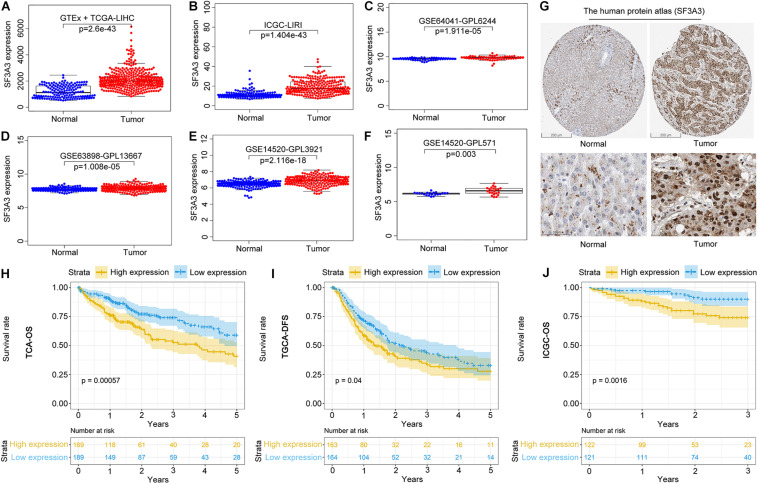
Pooled analyses of the expression profile of SF3A3 were investigated using publicly available data sets in liver hepatocellular carcinoma (LIHC). SF3A3 expression in publicly available data sets. (A) GTEx + The Cancer Genome Atlas (TCGA)-LIHC. (B) International Cancer Genome Consortium (ICGC)-LIRI. (C) GSE64041-GPL6244. (D) GSE63898-GPL13667. (E) GSE14520-GPL3921. (F) GSE14520-GPL571. (G) Expression of SF3A3 protein in LIHC tissues and normal liver tissues (HPA). Scale bars, 200 and 50 μm. Kaplan–Meier survival analyses showing SF3A3 expression as overall survival (OS) (H) and disease-free survival (DFS) (I) in LIHC (TCGA-LIHC). (J) Kaplan–Meier survival analyses showing SF3A3 expression as OS in LIHC (ICGC-LIRI).